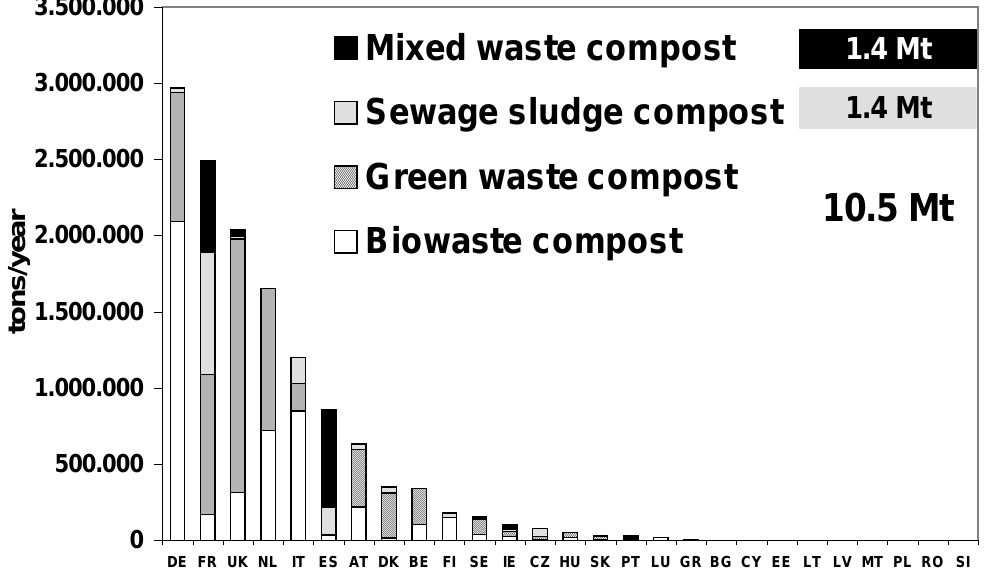
Figure 22: Compost produced in EU27 – differentiated for compost types – biowaste / green waste / sewage sludge / mixed waste